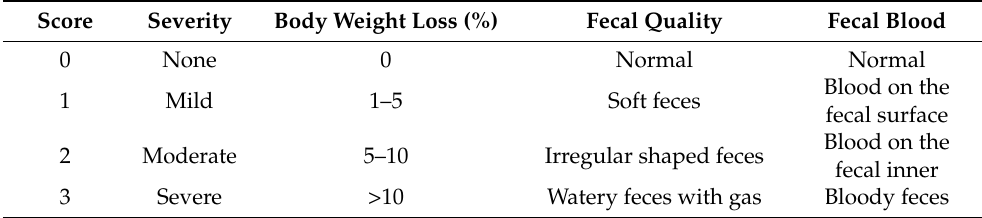
Table 2. Scores of DAI in the Broiler Chicken DSS-Induced Enteritis Model.